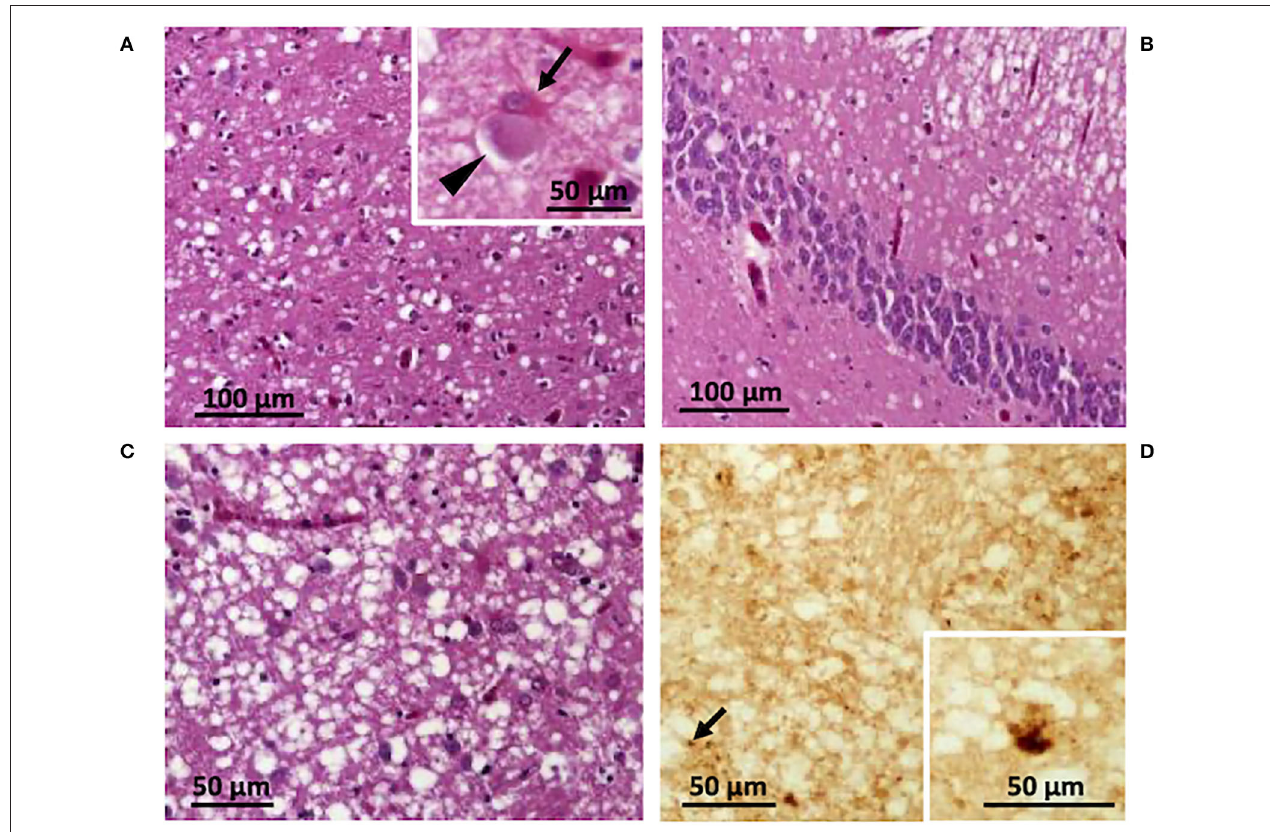
FIGURE 3 | Histological and immunohistochemical features. Spongiform degeneration with intermediate size vacuoles affecting cortical (A,B) and subcortical regions (C) ; inset in (A) a ballooned neuron ( arrowhead ) and a reactive astrocyte ( arrow ). (D) Immunohistochemistry showing PrP granules ( arrow ) and dispersed deposits of larger PrP aggregates (inset). (A) Parietal cortex; (B) hippocampus; (C,D) putamen. Antibody: